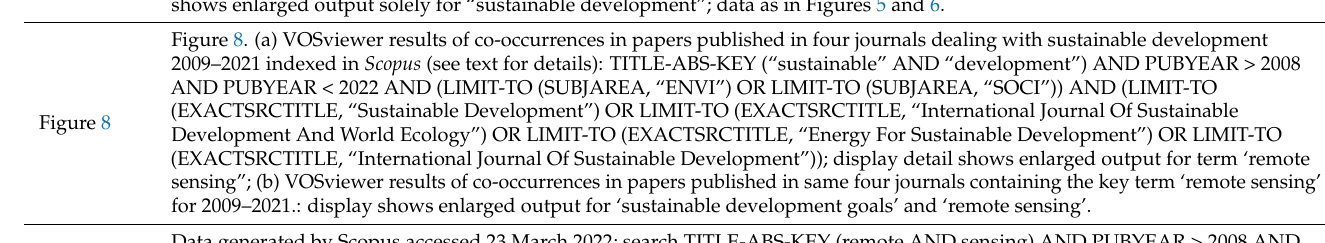
Figure Parameters Used in the Analysis Data generated by Scopus, accessed 29 May 2022. Search for “VOSviewer” in Title, Abstract and Keywords, 2010 (software first Figure 1 published)-2021 (last full year); TI = (“VOSviewer”) OR AB = (“VOSviewer”) OR AK = (“VOSviewer”). Graph created in Excel. Data generated by Web of Science , accessed 3 March 2021. Search for keywords “smart” and “sustainable”, refined by ‘city’; Figure 2 (TITLE-ABS-KEY (“smart” AND “sustainable”) AND PUBYEAR > 2014 AND PUBYEAR < 2021) AND (“city”); results limited to 1000 most cited papers published in WoS 2015–2020; VOSviewer display of co-occurrences limited to keyword threshold 10. Data generated by Scopus , accessed 1 March 2022; all publications in the journal Remote Sensing for full years from inception Figure 3 2009–2021; TITLE-ABS-KEY (“remote sensing”) AND PUBYEAR > 2008 AND PUBYEAR < 2022 AND (LIMIT-TO (EXACTSRCTITLE, “Remote Sensing”)); VOSviewer display of co-occurrences limited to keyword threshold 150. The use of key terms “sustain” OR “sustainable” in the journal Remote Sensing, 2009–2021; (TITLE-ABS-KEY (“remote sensing”) Figure 4 AND PUBYEAR > 2008 AND PUBYEAR < 2022) AND (“sustain” OR “sustainable”) AND (LIMIT-TO (EXACTSRCTITLE, “Remote Sensing”)); graph created in Excel. VOSviewer results of co-occurrences in papers published in Remote Sensing 2009–2018 with key terms “sustain” OR “sustainable development”; (TITLE-ABS-KEY (“remote sensing”) AND PUBYEAR > 2008 AND PUBYEAR < 2019) AND (“sustain” OR Figure 5 “sustainable”) AND (LIMIT-TO (EXACTSRCTITLE, “Remote Sensing”)); VOSviewer display of co-occurrences limited to keyword threshold 10. VOSviewer results of co-occurrences in papers published in Remote Sensing in 2021 with key terms “sustain” or “sustainable development”; (TITLE-ABS-KEY (“remote sensing”) AND PUBYEAR > 2008 AND PUBYEAR < 2022) AND (“sustain” OR Figure 6 “sustainable”) AND (LIMIT-TO (EXACTSRCTITLE, “Remote Sensing”)) AND (LIMIT-TO (PUBYEAR, 2021)); VOSviewer display of co-occurrences limited to keyword threshold 10. Figure 7. (a) VOSviewer results of co-occurrences among papers published in Remote Sensing 2009–2021 with key terms “sustain” OR “sustainable development”; display shows enlarged output solely for ‘sustainable development’; (b) VOSviewer results of Figure 7 co-occurrences in papers published in Remote Sensing solely in 2021 with key terms “sustain” or “sustainable development”; display shows enlarged output solely for “sustainable development”; data as in Figures 5 and 6. Figure 8. (a) VOSviewer results of co-occurrences in papers published in four journals dealing with sustainable development 2009–2021 indexed in Scopus (see text for details): TITLE-ABS-KEY (“sustainable” AND “development”) AND PUBYEAR > 2008 AND PUBYEAR < 2022 AND (LIMIT-TO (SUBJAREA, “ENVI”) OR LIMIT-TO (SUBJAREA, “SOCI”)) AND (LIMIT-TO (EXACTSRCTITLE, “Sustainable Development”) OR LIMIT-TO (EXACTSRCTITLE, “International Journal Of Sustainable Figure 8 Development And World Ecology”) OR LIMIT-TO (EXACTSRCTITLE, “Energy For Sustainable Development”) OR LIMIT-TO (EXACTSRCTITLE, “International Journal Of Sustainable Development”)); display detail shows enlarged output for term ‘remote sensing”; (b) VOSviewer results of co-occurrences in papers published in same four journals containing the key term ‘remote sensing’ for 2009–2021.: display shows enlarged output for ‘sustainable development goals’ and ‘remote sensing’. Data generated by Scopus accessed 23 March 2022; search TITLE-ABS-KEY (remote AND sensing) AND PUBYEAR > 2008 AND Figure 9 PUBYEAR < 2022 AND (LIMIT-TO (EXACTSRCTITLE, “Sustainability Switzerland”)); VOSviewer results of co-occurrences in papers published in journal Sustainability 2009–2021 with key terms “remote AND sensing”; display limited to keyword threshold